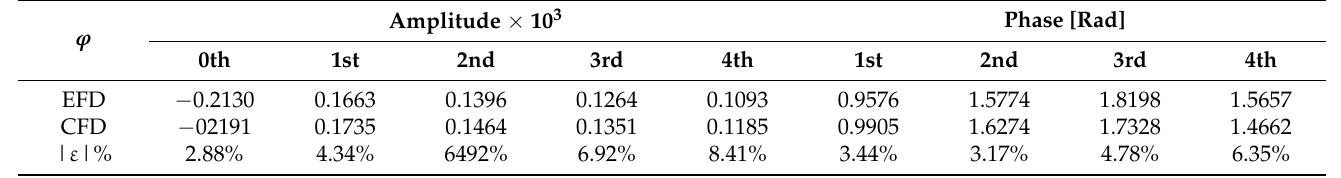
Table 17. Harmonic amplitudes and phases of roll ( ϕ ) for the FRxz ϕθ beam waves scenario.